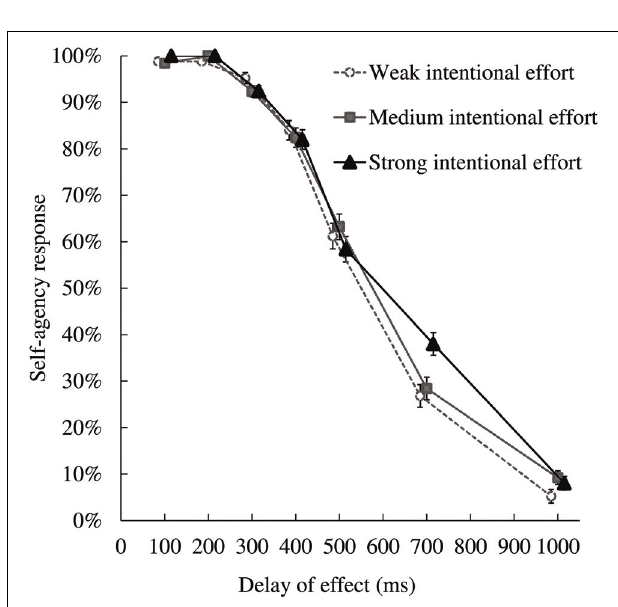
FIGURE 2 | Mean proportions of self-responses in the self–other attribution task. Error bars represent within-subject standard errors for each delay condition, as computed according to Loftus and Masson’s (1994) method. The self-agency response rate decreased with increasing delay, and was greater in the strong intentional effort condition than in the weak and medium intentional effort conditions when the delay of effect was 700